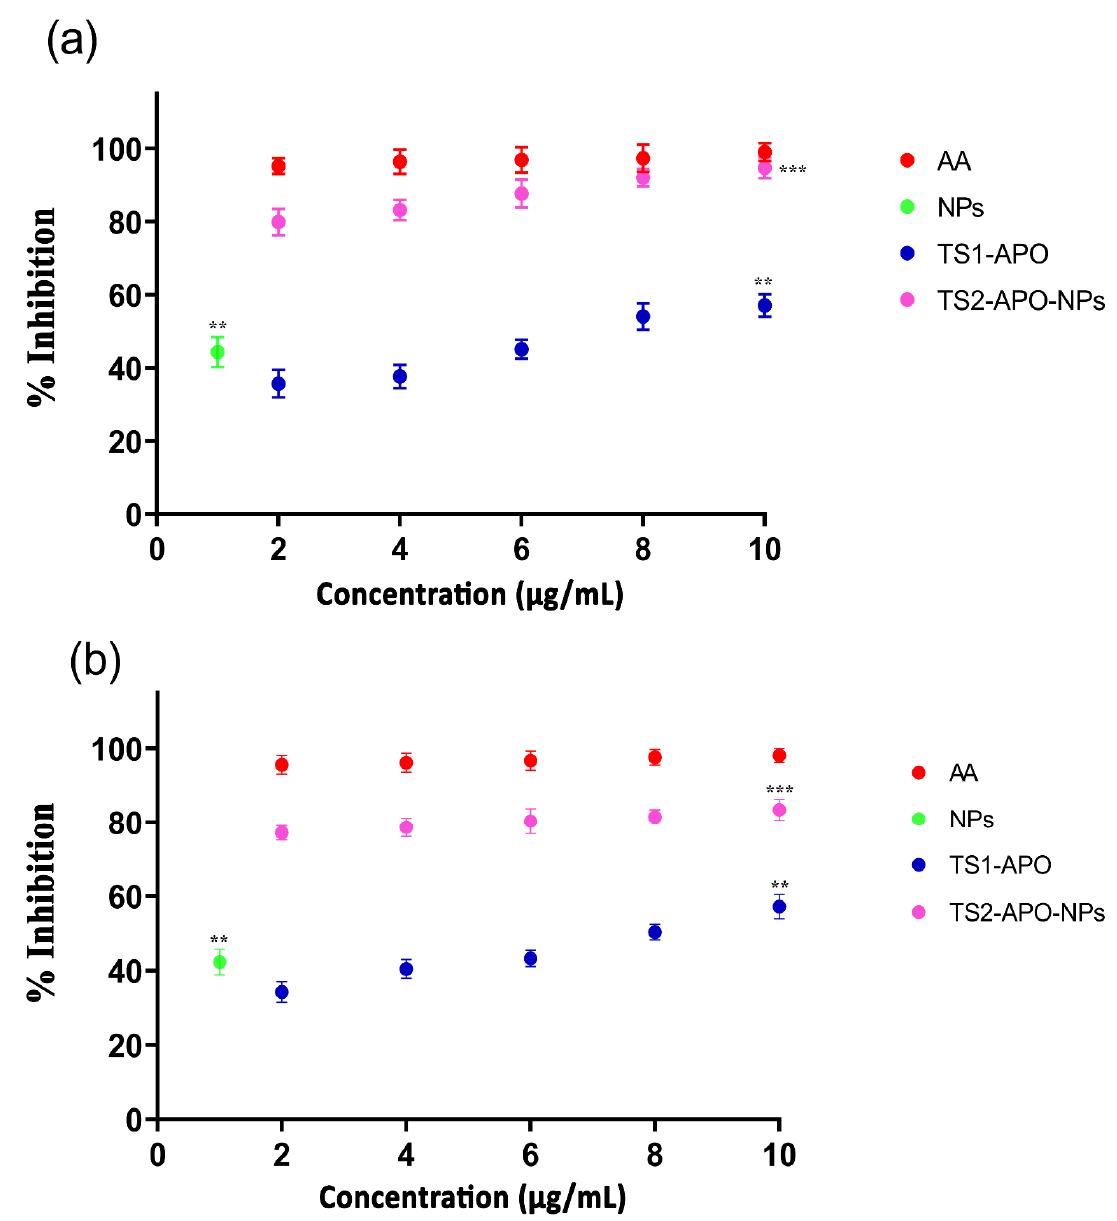
Figure 8. ( a , b ): The AO graph represents a comparative effect of APO-NPs on antioxidant ability against APO and the control (Ascorbic acid—AA) at 12 and 24 h, respectively. Data is expressed in terms of mean ± SEM (n = 3), significant changes are given as ** p < 0.05 and *** p < 0.01, as compared to APO and the control. The graph showed that APO-NPs have better antioxidant ability than the other comparative groups. Abbreviations: APO = Apocynin pure compound; APO- NPs = Apocynin loaded optimized chitosan—PCL nanoparticles; NPs = Only chitosan—PCL optimized nanoparticles without any compound; AA = Ascorbic acid as positive control.